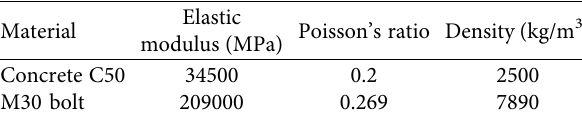
Figure 4: The magnified view of the bolts for the shield tunnel joints. Table 1: Material properties of the shield tunnel lining.